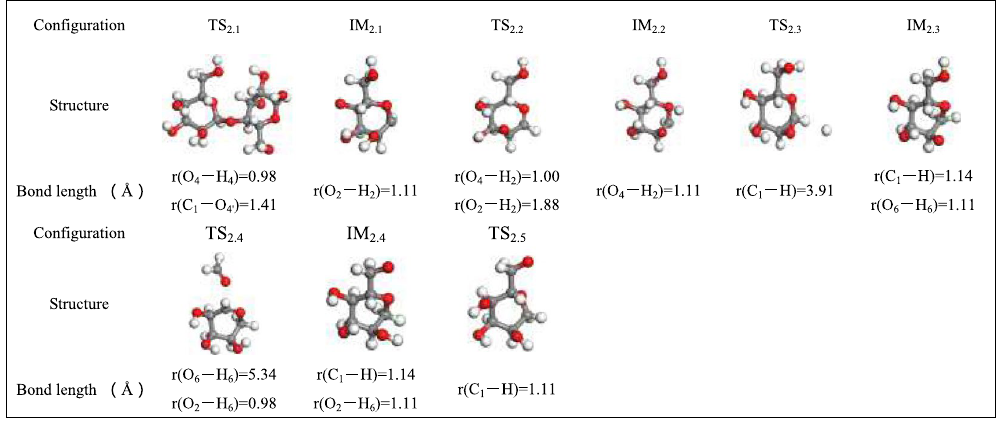
Table 3. Optimized configuration in pathway